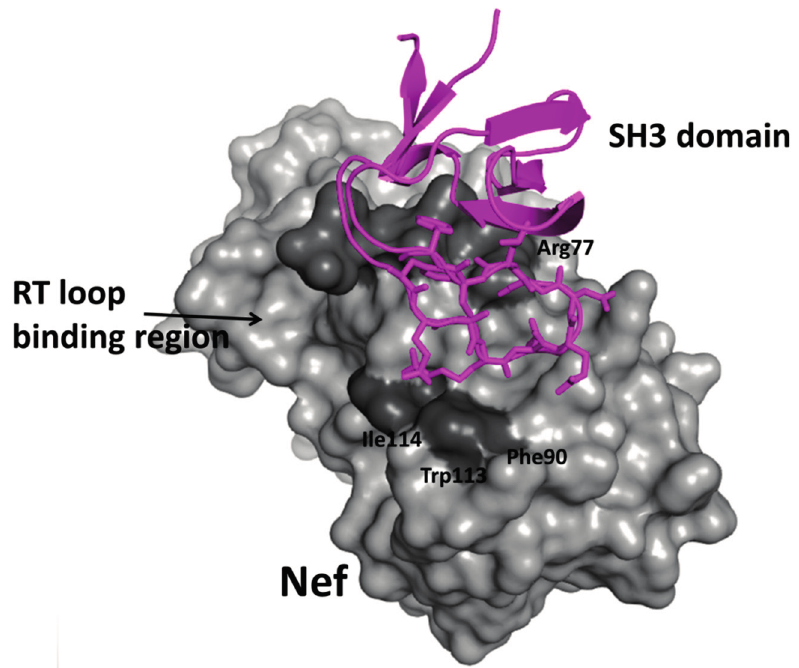
Figure 6. Crystal structure of HIV-1 nef-SH3 domain (PDB ID:1AVZ). Nef is shown in surface representation and SH3 domain in magenta. Note the interaction of SH3 domain with hydrophobic grove that is called RT loop binding region. Residues surround the groove are shown in dark shade. Compounds were screened based on RTloop binding region [235]. PyMol (Schrodinger LLC) was used to generate the figure based on the information from Betzi et al. [235]. Permission obtained. Copyright (2007) National Academy of Sciences,